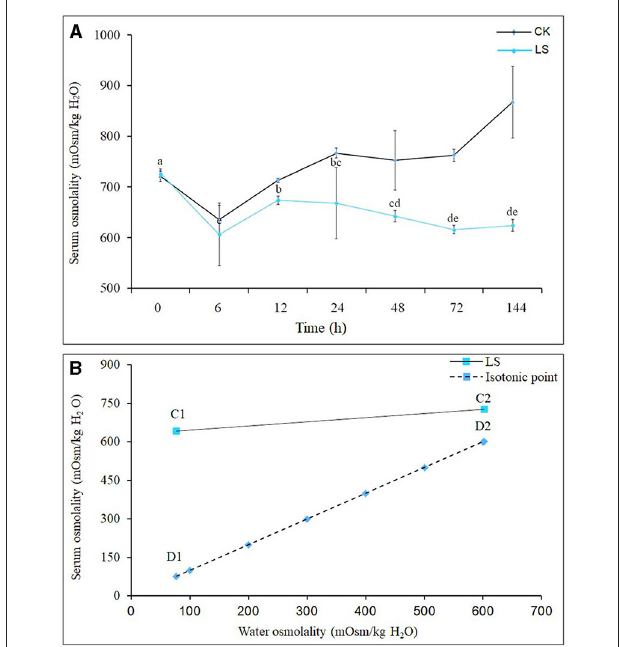
FIGURE 1 | Effect of salinity on hemolymph osmolality of S.paramamosainn; (A) shows the changes in osmolality of S.paramamosainn under the change of salinity; (B) is the osmolality isotonic map of S.paramamosainn and seawater. In the (B) , D1 and C1 are the hemolymph osmolality in S.paramamosain at the salinity 23 and 3, respectively, and C2 and D2 are the seawater osmolality at the 23 and 3 psu,